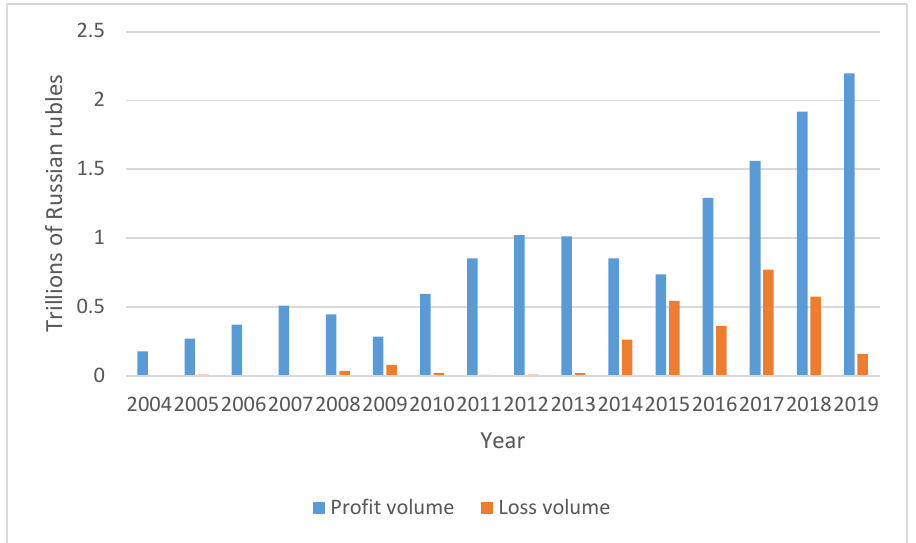
Figure 1. Profits and losses of banks without innovative mobile trading apps in 2004–2019 years. Figure 2 reflects the dynamics of profitability of banking activities by corresponding financial institutions. It can be observed that through the years, the positive cash flow of banks has been steadily declining, leading to the emergence of companies losing money. The record-breaking highs and peaks leading to the 2008 mortgage crisis have not been restored in the last decade, signaling a shifting paradigm in Russia’s banking sector.